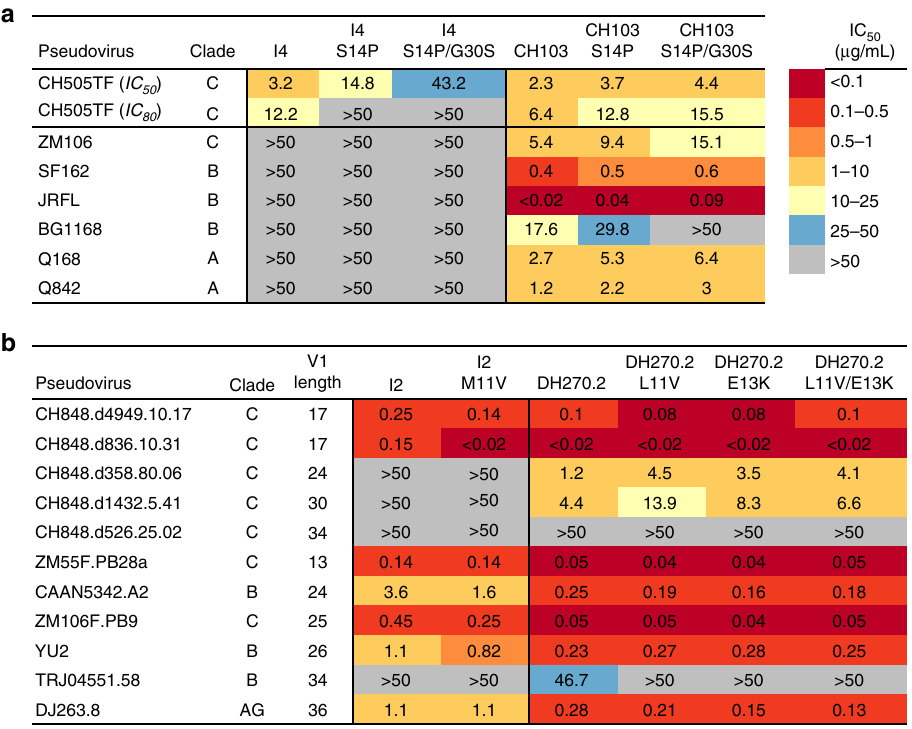
Fig. 6 Effect of reversion mutations on neutralization potency and breadth. a Antibody neutralization of the wild-type and reversion mutants of the CH103 lineage intermediate I4 and the CH103 bnAb against autologous and heterologous Env-pseudoviruses. b Antibody neutralization of the wild-type and reversion mutants of the DH270 lineage intermediate I2 and the DH270.2 bnAb against autologous and heterologous Env-pseudoviruses. Antibody neutralization was measured by a TZM-bl cell-based assay using a select panel of geographically and genetically diverse Env-pseudoviruses. All values are IC 50 ( µ g/mL) unless otherwise